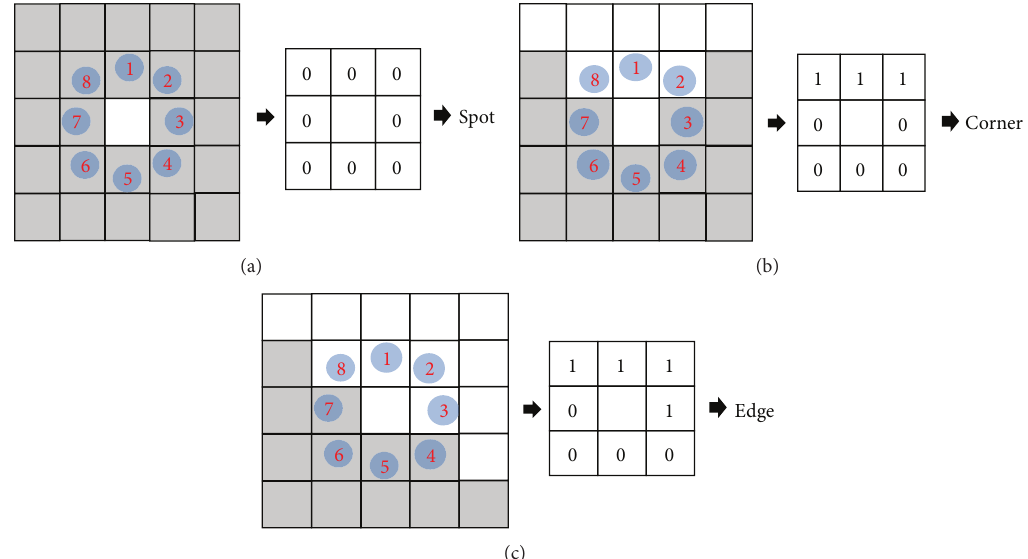
Figure 7: Examples of uniform patterns in describing the texture features: (a) spot feature, (b) corner feature, and (c) edge feature.